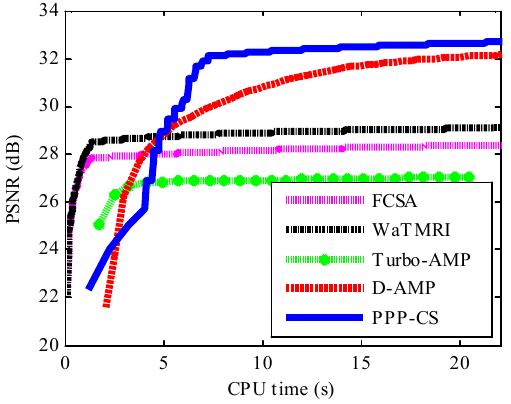
Figure 5. Performance comparison (CPU time vs. PSNR) with 20% sampling.